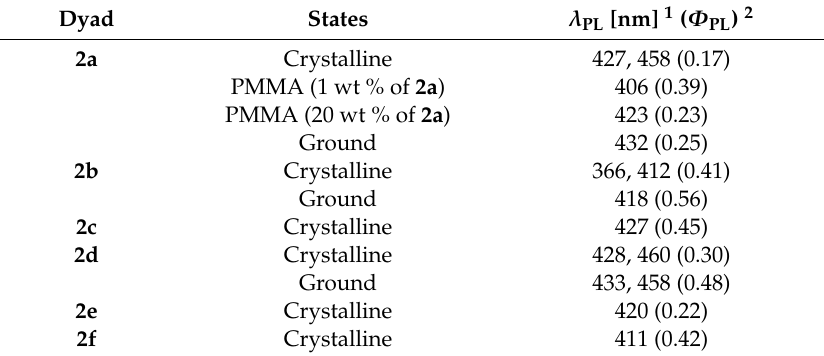
Table 3. Photophysical parameters of 2a – f in the molecular aggregated